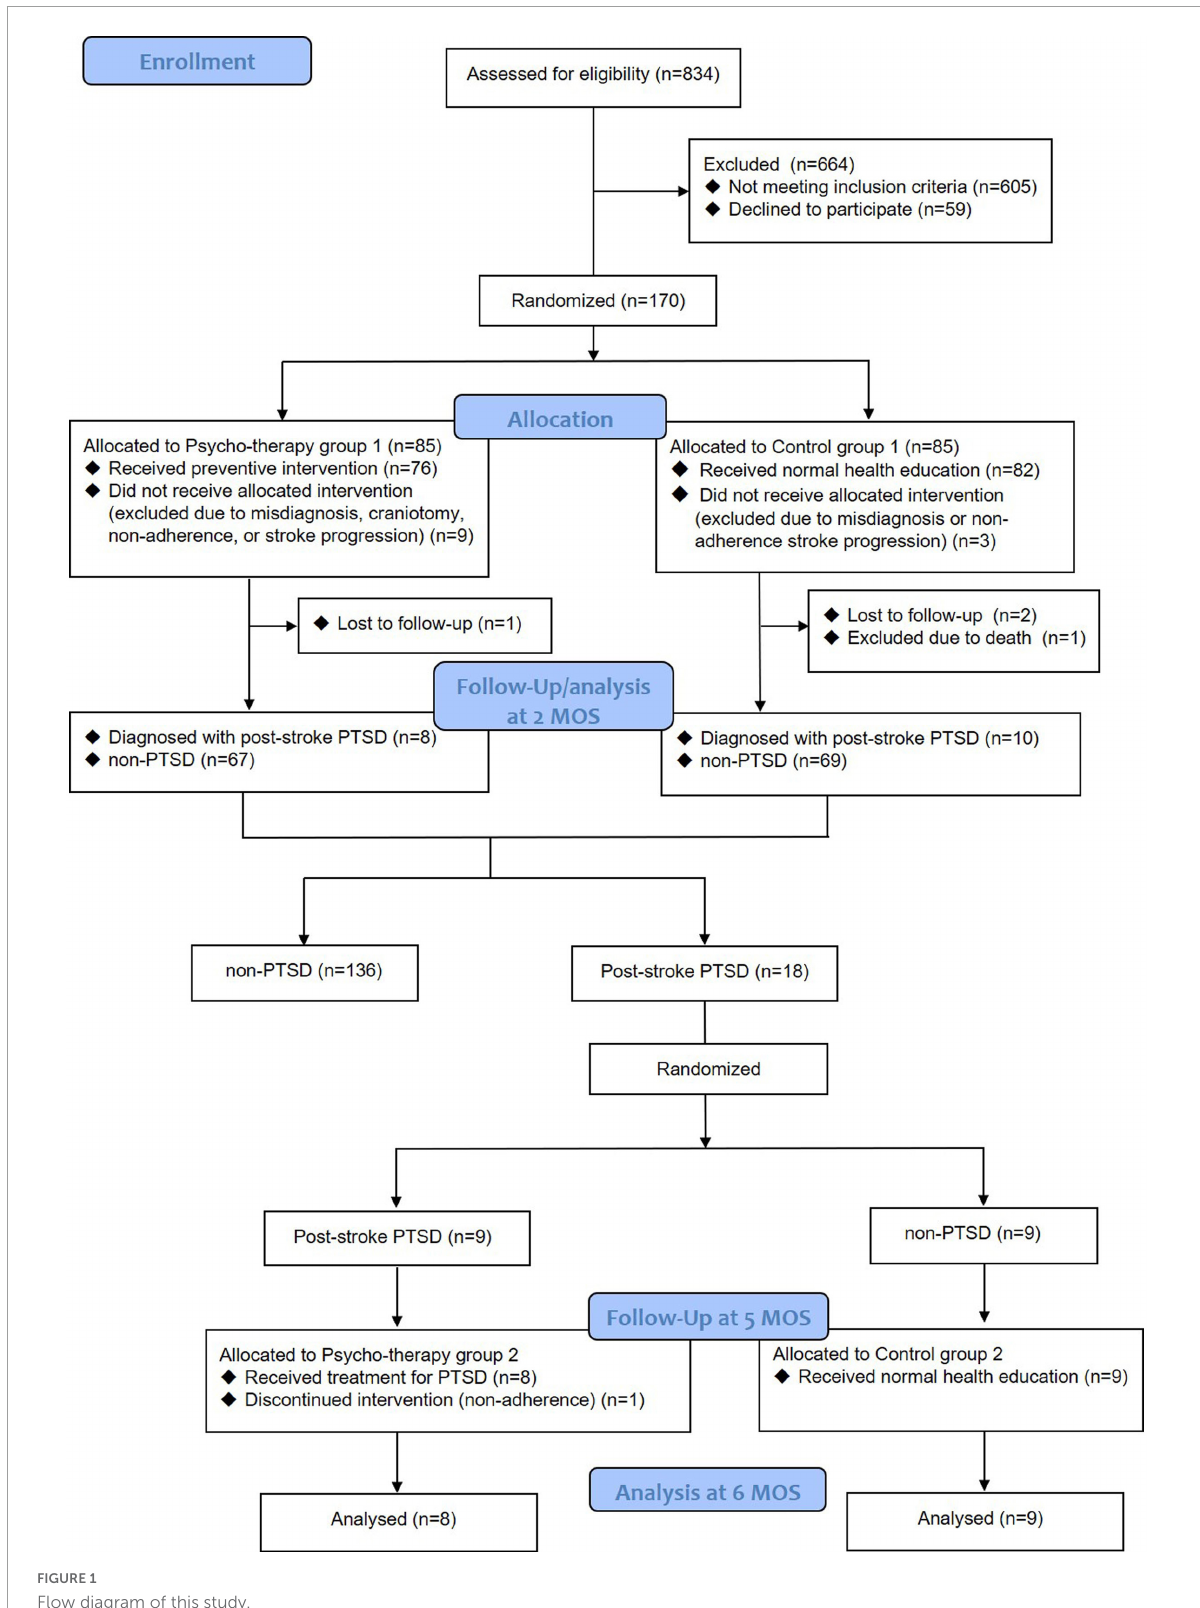
FIGURE1 Flow diagram of this